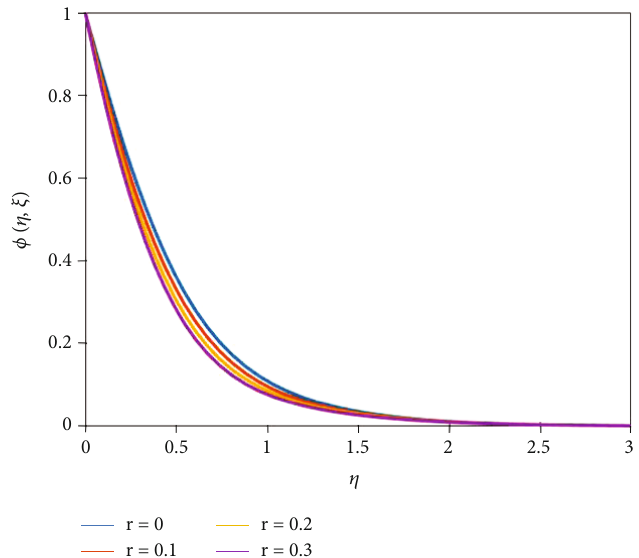
: 8, ξ = 1, N N Df = Sr = Bi = 0 : 5, He = b = t = w = 0